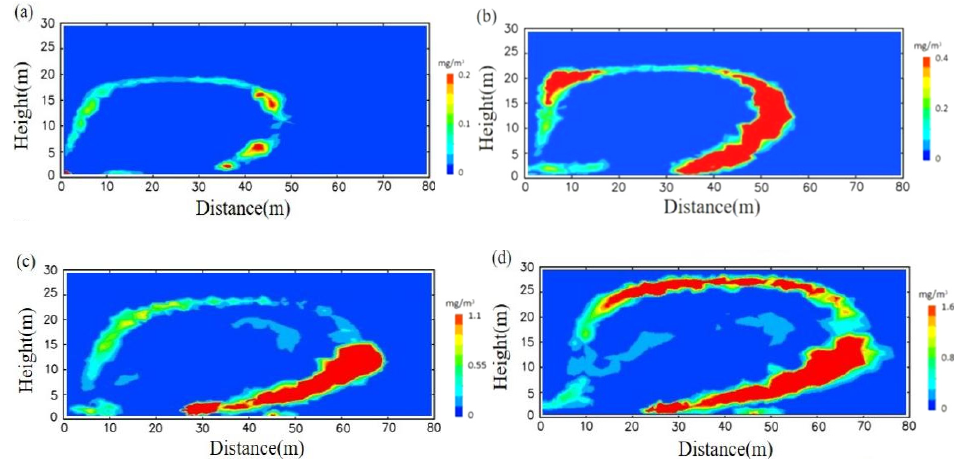
Figure 6. PM concentration profiles at vertical direction at 30 m heights by CFD technology: ( a ) PM 1 ; ( b ) PM 2.5 ; ( c ) PM 10 ; and ( d ) TSP (outside).